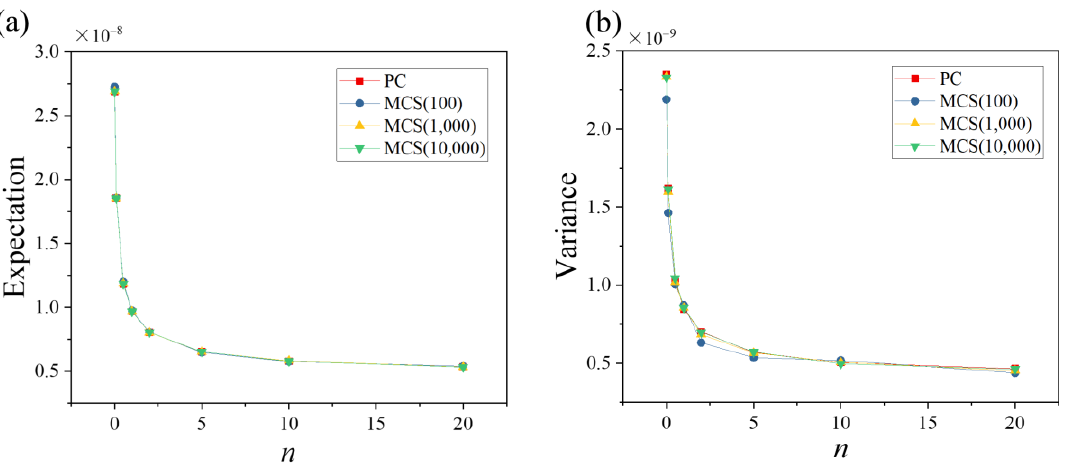
Figure 8. The expectation and standard variance of deflection calculated by PCE and MCS: ( a ) ex- pectation; ( b ) standard variance.